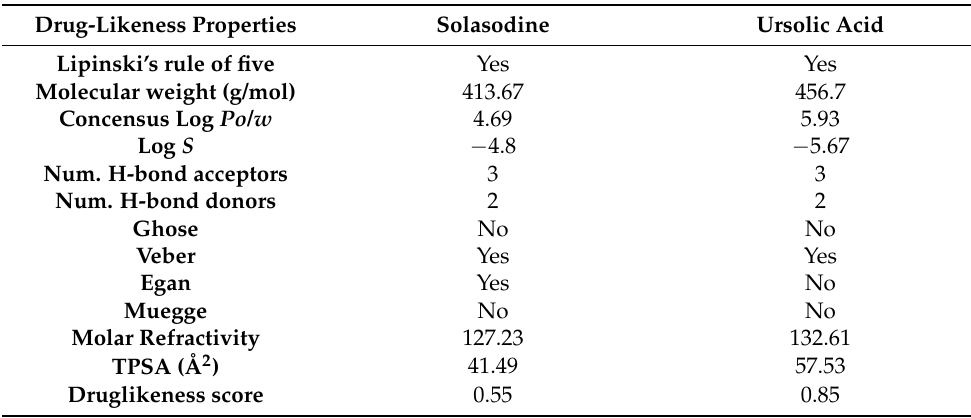
Table 3. Drug-likeness property studies of selected ligand molecules.